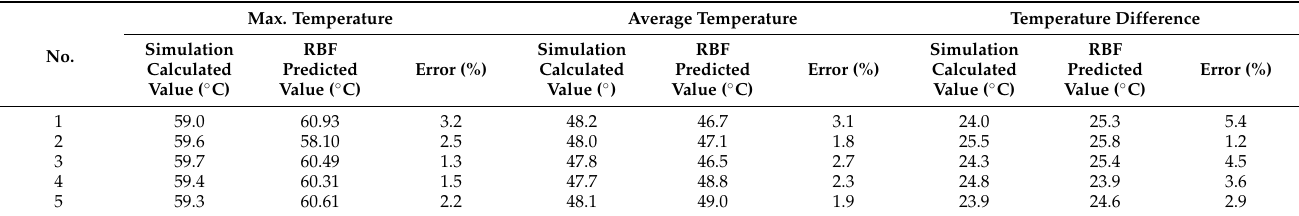
Table 6. Comparison and error analysis between predicted and calculated values.